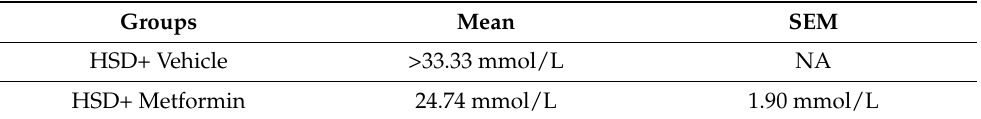
Table 1. Blood glucose levels in vehicle- or metformin-treated db/db mice maintained on a high salt diet (HSD) ( N = 8).